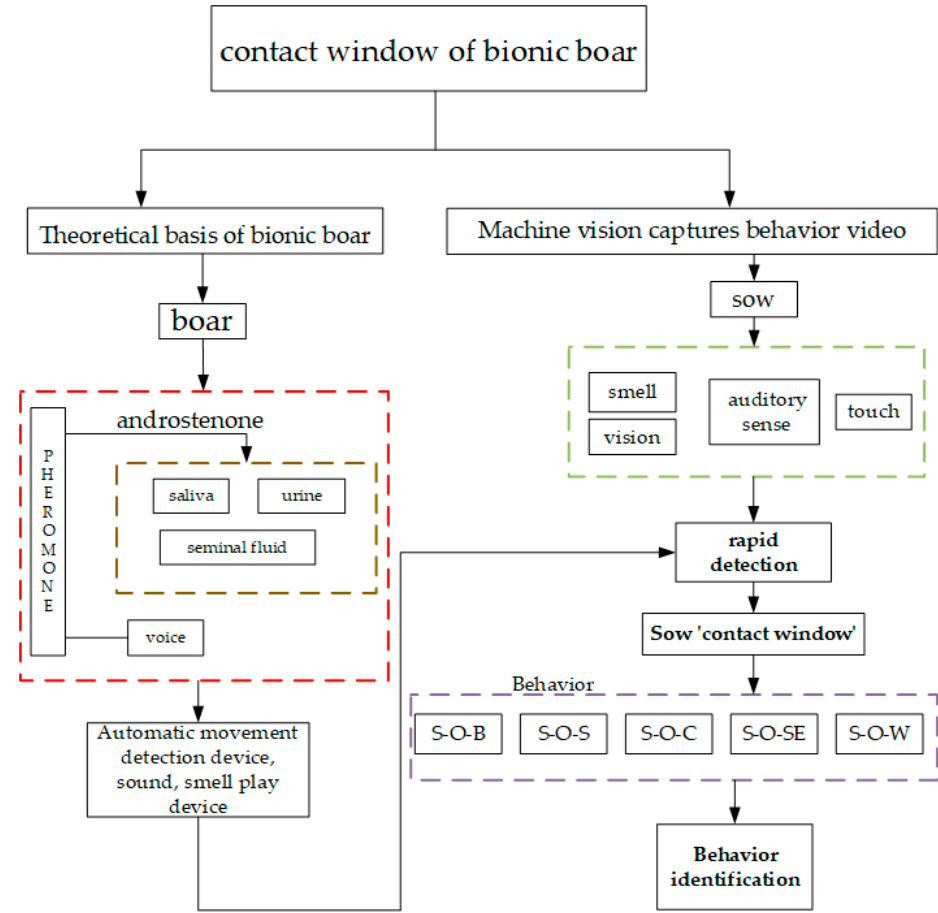
Figure 2. Technical roadmap. Note: S-O-B denotes that a sow in the oestrous cycle bites the rod; S-O-S denotes that the sow stands still during the oestrus cycle; S-O-C denotes that the sow touches the bionic boar snout during the oestrus cycle; S-O-SE denotes that the sow’s ears stand still during the oestrus cycle; S-O-W denotes that the sow moves her head over a wide range during the oestrus cycle.